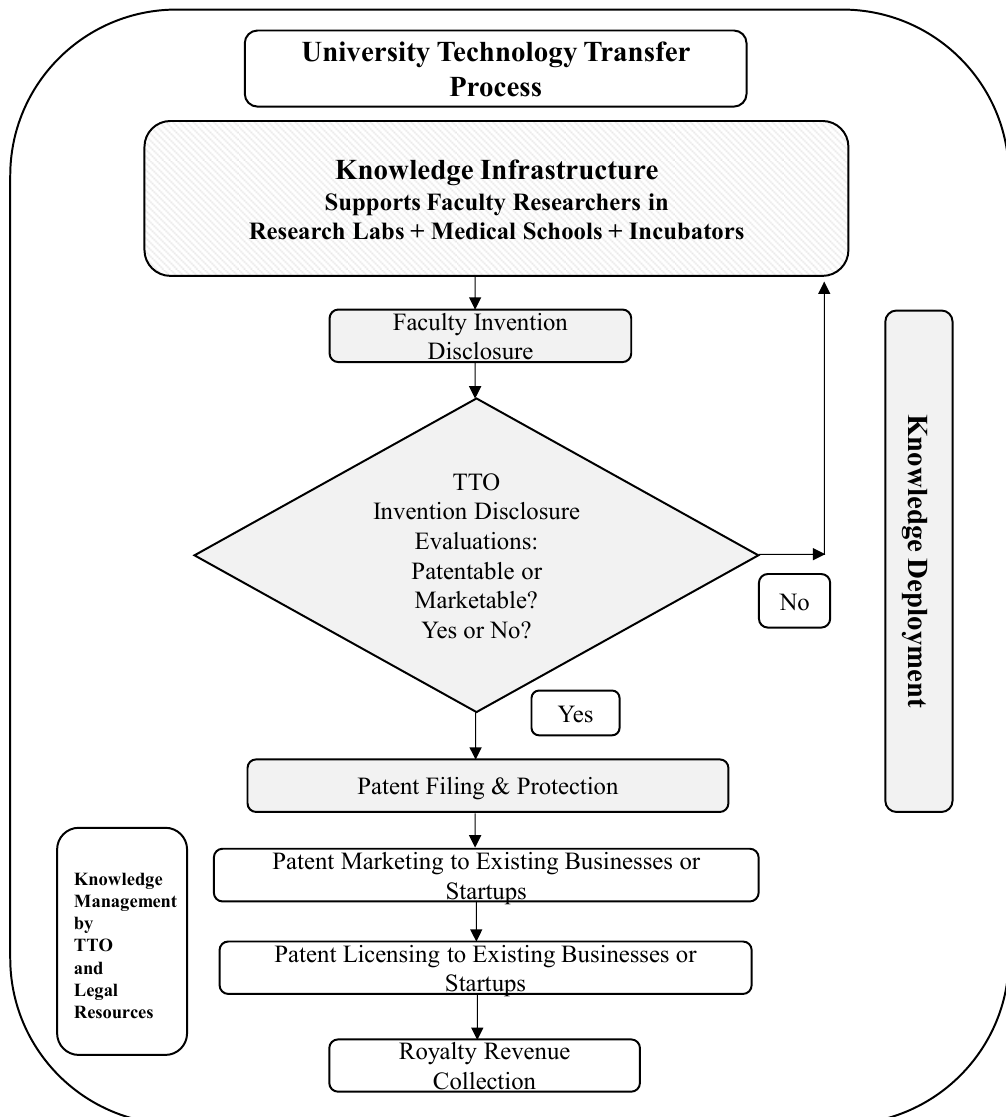
Figure 1. Conceptual Model for University Technology Transfer based on the Knowledge Based View (KBV).